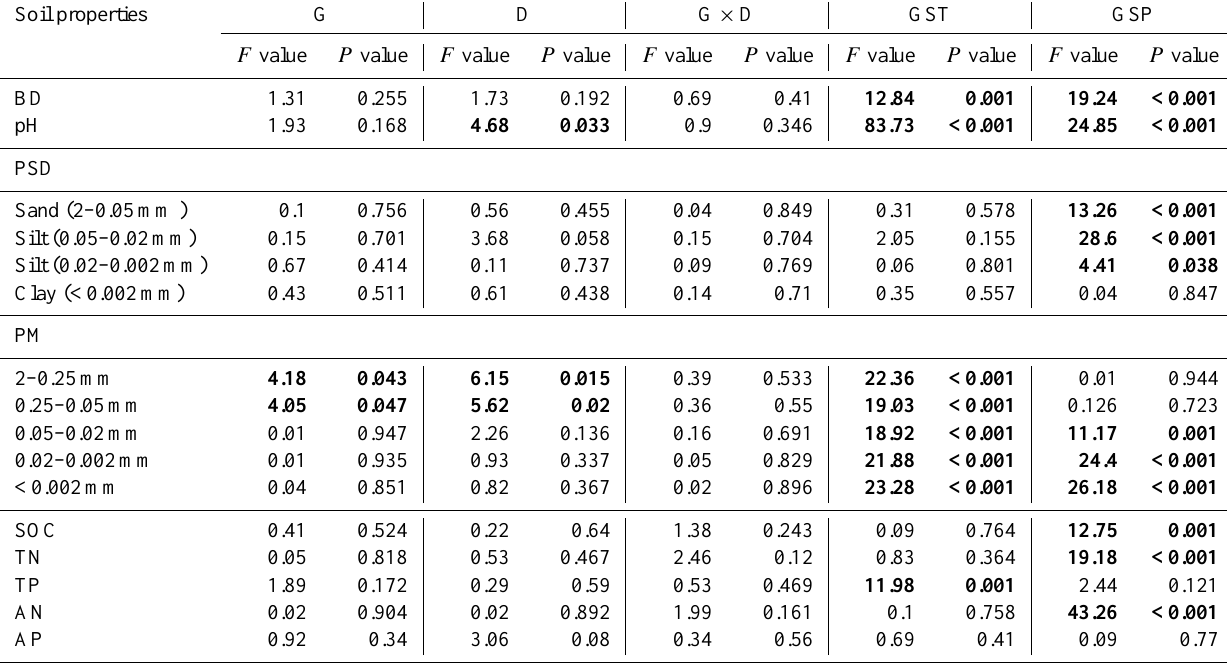
Table 2. Results from analysis of covariance (ANCOVA) by the general linear model (GLM) showing F and P values of soil properties and nutrients, in which the fixed factor was grazing treatments (G: free-grazing and grazing exclusion) and soil depth (D: 0–15 and 15–30cm), while the covariates were growing season temperature (GST) and growing season precipitation (GSP). P values below 0.05 are in bold.